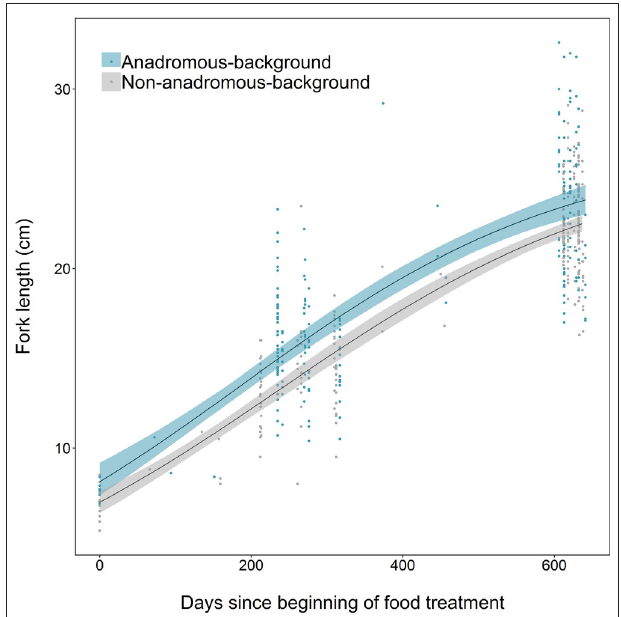
FIGURE 5 | Growth curves, based on length measurements spanning 2 years of experimental tank-rearing, of brown trout classed as either smolt (migratory) or freshwater maturing (resident) in Spring 2018. Fitted lines are based on the best-fitting parameters from the logistic growth model, fitted using non-linear least squares regression. Shaded areas represent the 95% confidence intervals constructed by bootstrapping for 10,000 iterations.